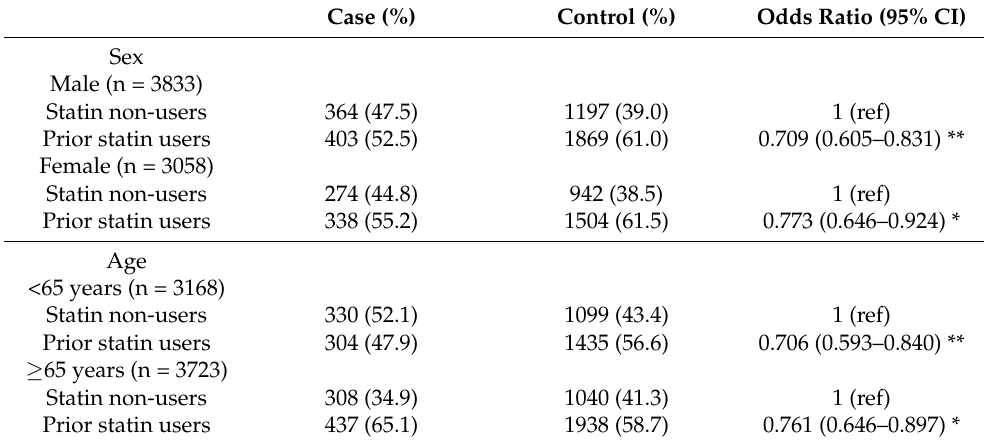
Table 4. Subgroup analysis by sex and age for the associations between statin use and risk of sensorineural hearing loss or